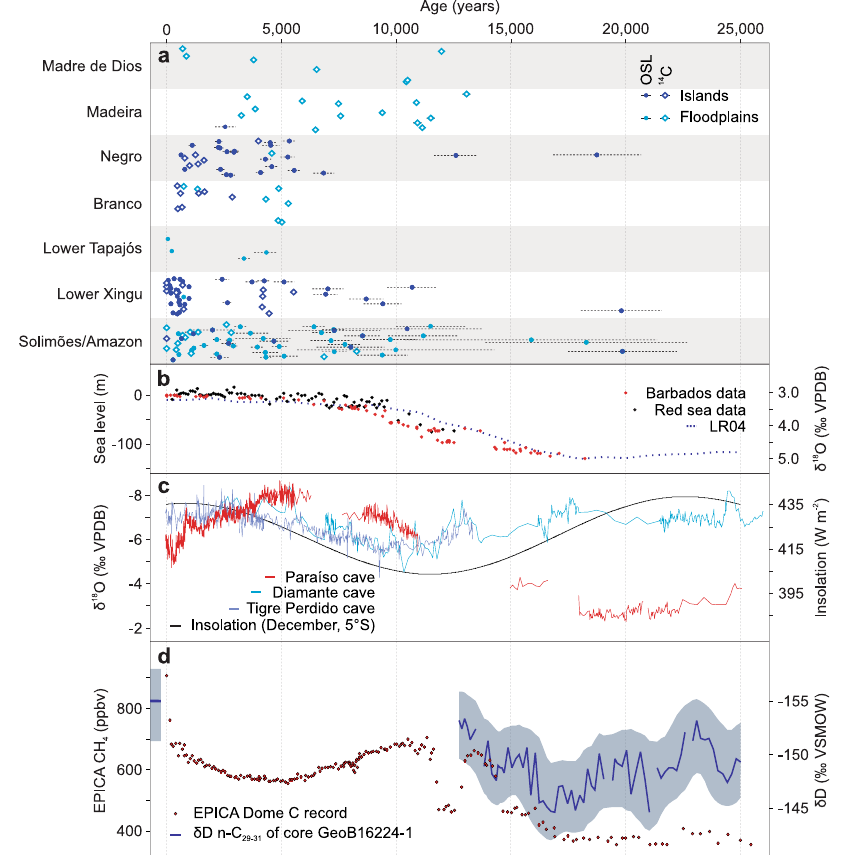
Fig. 7 | Summary of results (last 25ka). OSL and radiocarbon ages ( a ) are com- pared to sea level variation ( b ), precipitation records across Amazonia ( c , d ) and atmospheric methane (CH 4 ) concentration ( d ). OSL and radiocarbon ages have an offset in the y -axis to avoid symbol overlap and allow visualization. In a , dots represent sediment sample ages and horizontal bars represent age errors calcu- lated according to the Gaussian law of error propagation. Sea level variation combines global records 40 – 42 and is considered representative of the equatorial Atlantic Ocean. Precipitation records ( c ) correspond to stable oxygen isotopes